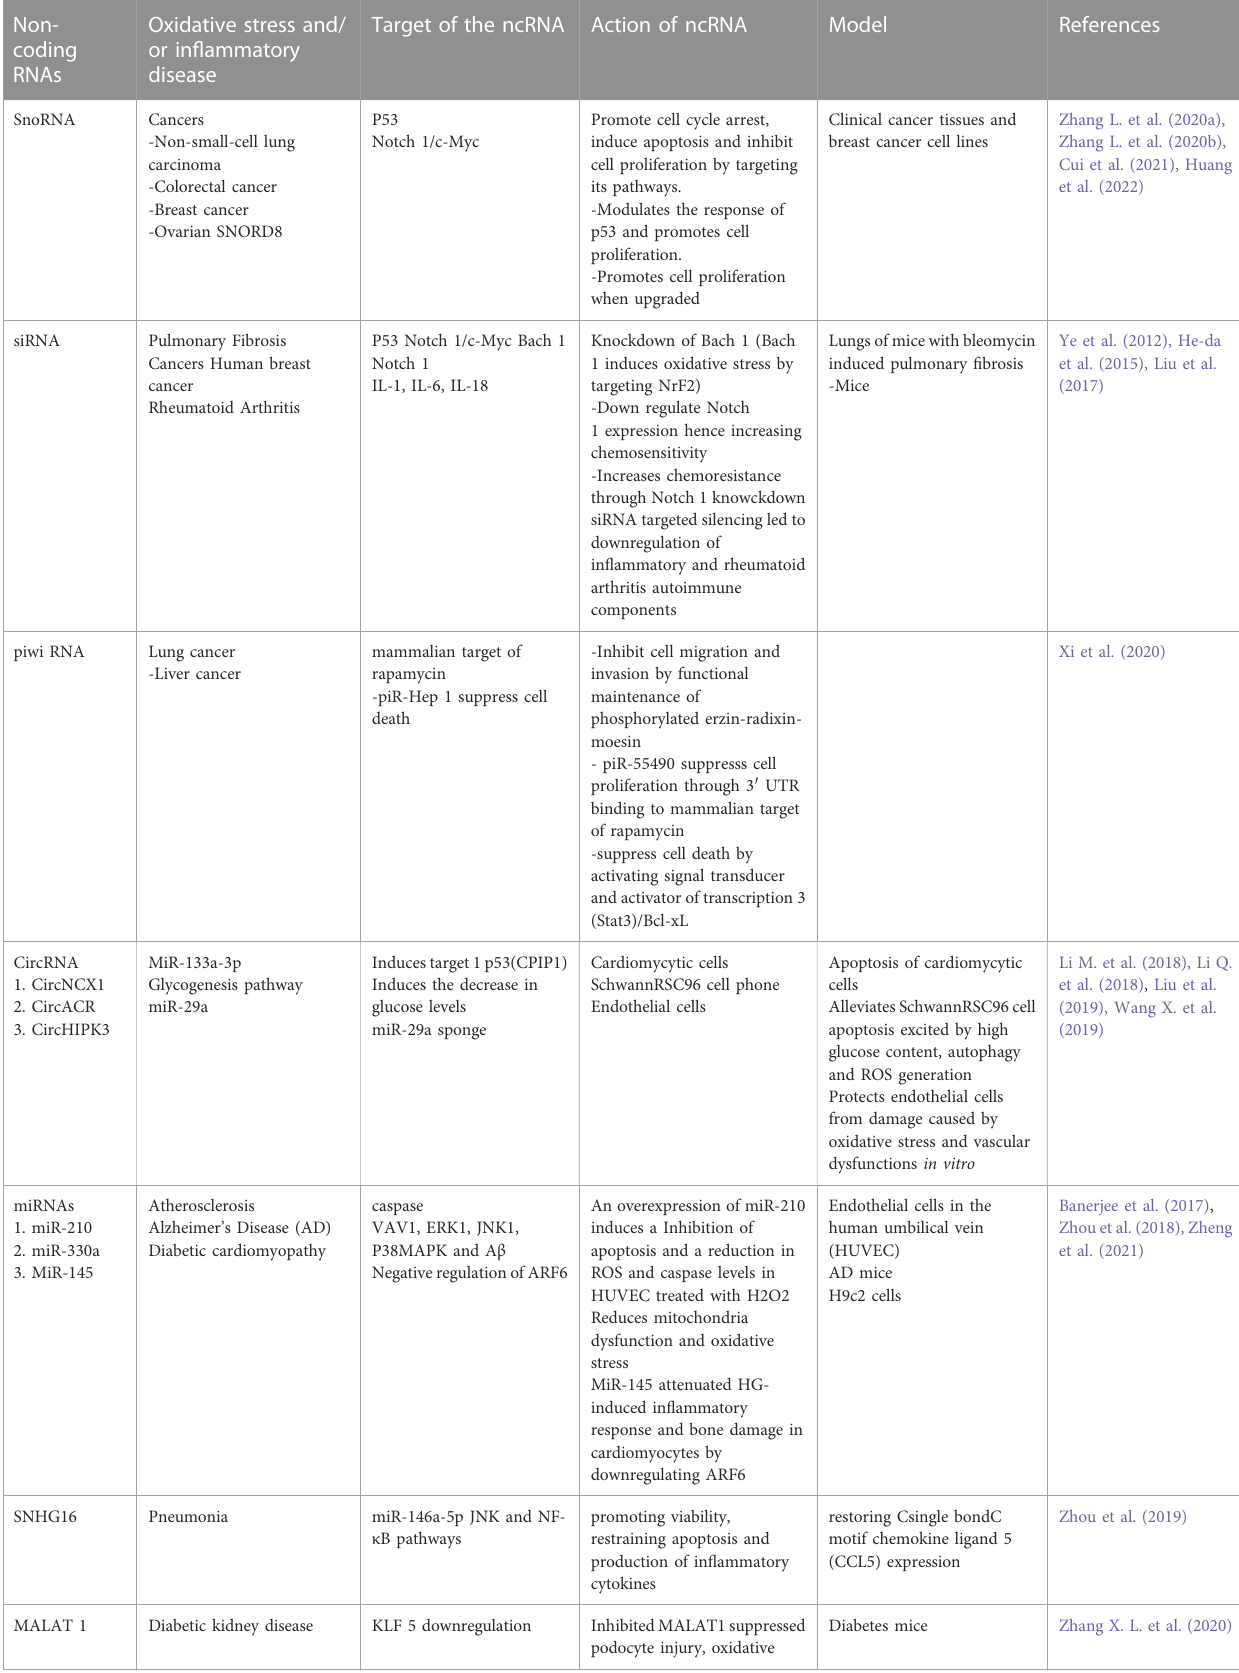
TABLE 4 Non-coding RNAs involved in Oxidative stress and In fl ammation related Disorders on which the Effect of Natural Products has not been Investigated. Non- coding